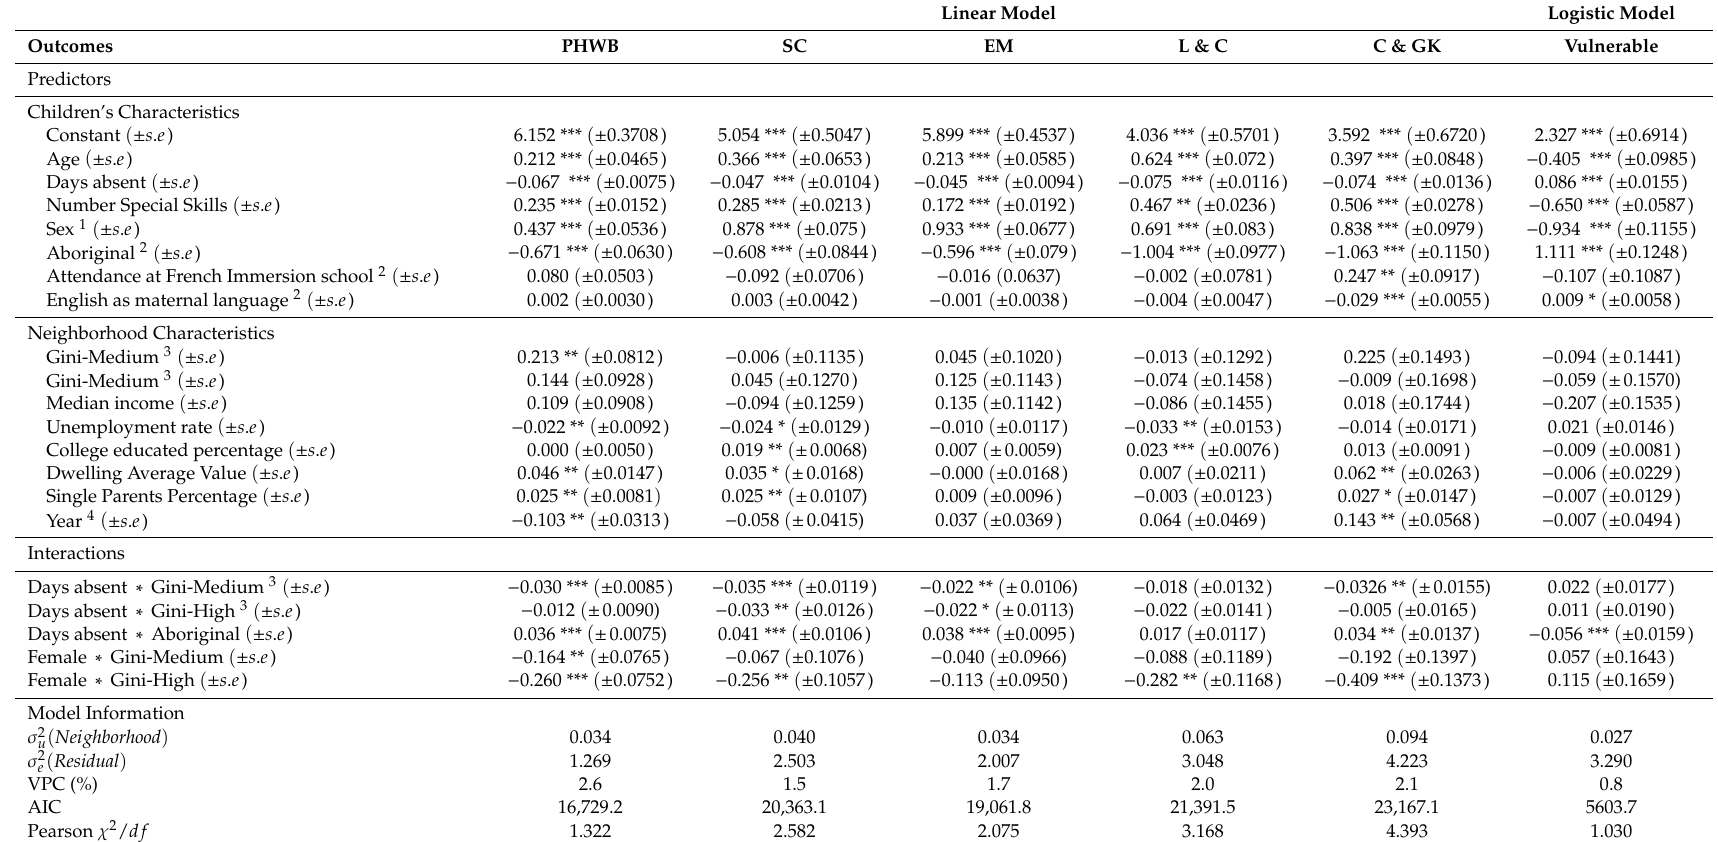
Table 2. Two-level generalized linear model and logistic model estimates ( n =